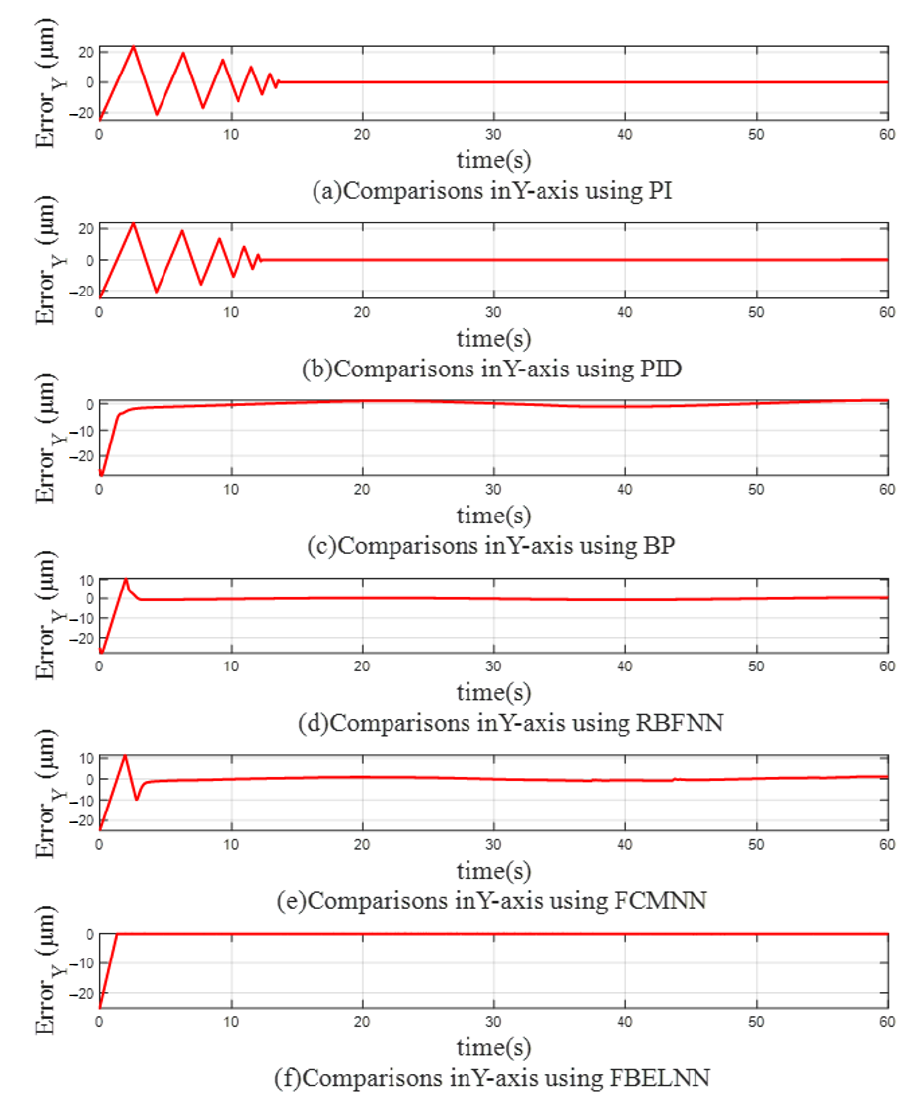
Figure 9. The trajectory error on the Y -axis (single cell manipulation): ( a ) Use PI as a controller. ( b ) Use PID as a controller. ( c ) Use BP as a controller. ( d ) Use RBFNN as a controller. ( e ) Use FCMNN as a controller. ( f ) Use FBELNN as a controller. Table 2. Root mean square error (RMSE) of single-cell